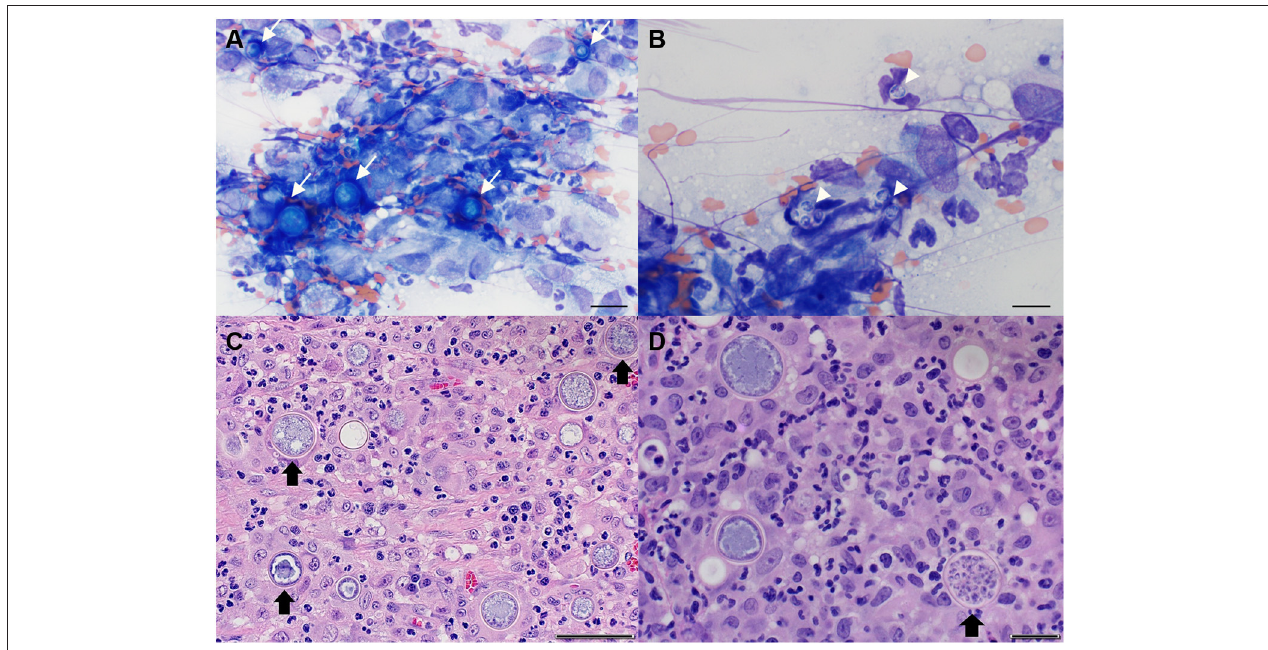
FIGURE 4 | Representative cytological images of sternal lymph node (A,B) and histopathological images of spinal cord granuloma (C,D) in a cat with spinal coccidioidomycosis. (A) Multiple immature Coccidioides spp. spherules (arrows) with surrounding pyogranulomatous inflammation. Wright-Giemsa, 50 × objective, Scale bar = 20 µ m; (B) Several free Coccidioides spp. endospores (arrowheads). Wright-Giemsa, 100 × objective, Scale bar = 10 µ m; (C) Neuroparenchyma obscured by mixed inflammation predominated by neutrophils and macrophages admixed with numerous Coccidioides spp. spherules (arrow). Hematoxylin and eosin (H and E). Scale bar = 50 µ m; (D) Occasional Coccidioides spp. spherules are filled with endospores (arrow) (H and E). Scale bar = 20 µ